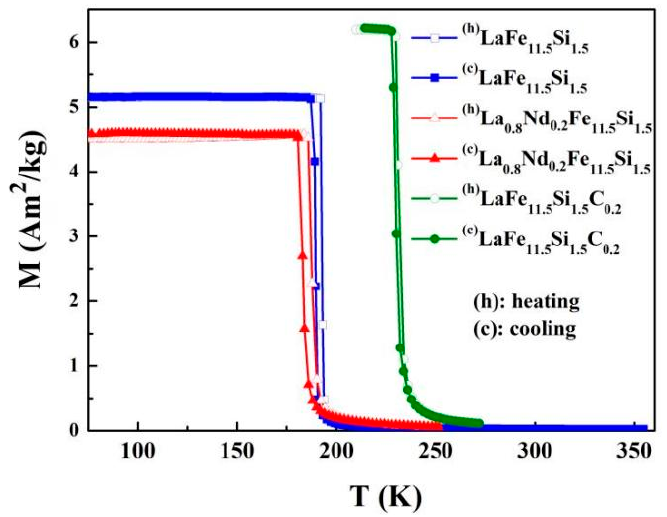
Figure 2. Temperature dependence of magnetization for LaFe 11.5 Si 1.5 , La 0.8 Nd 0.2 Fe 11.5 Si 1.5 , and LaFe 11.5 Si 1.5 C 0.2 under an external magnetic field of 0.01 T. The isothermal magnetization curves (i.e., M – H curves) of the LaFe 11.5 Si 1.5 , La 0.8 Nd 0.2 Fe 11.5 Si 1.5 , and LaFe 11.5 Si 1.5 C 0.2 measured in a wide temperature range under an